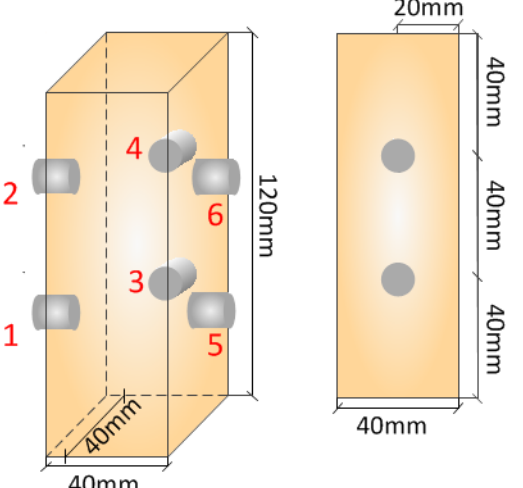
Figure 3. The layout of acoustic emission monitoring points.